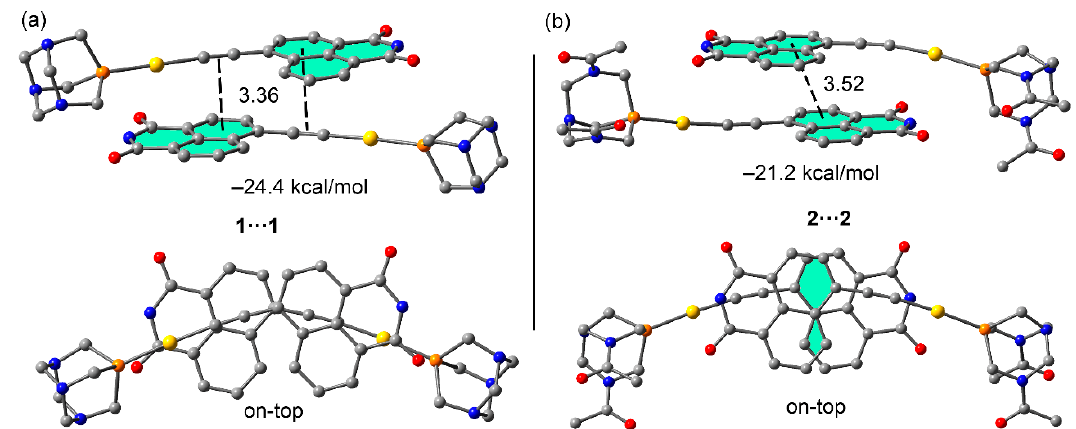
Figure 4. PB86-D3(COSMO)/def2-TZVP optimized geometries of the self-assembled dimers of 1 ( a ) and 2 ( b ). Distances in Å.